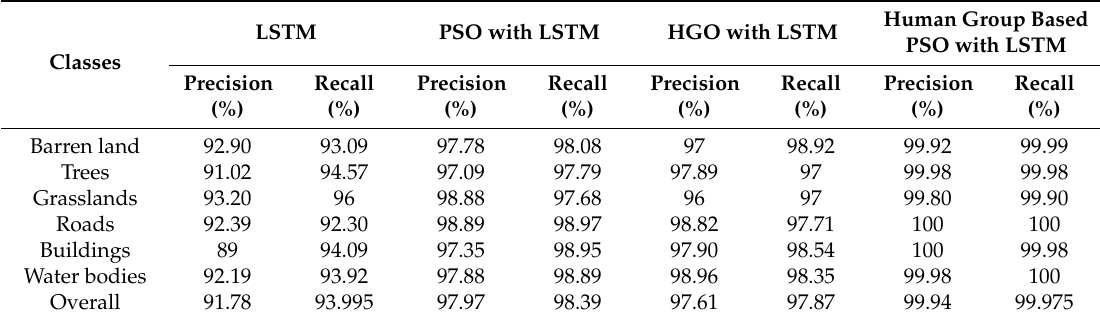
Table 11. Performance investigation of the proposed model with di ff erent optimization techniques on Sat 6 dataset by means of recall and precision.